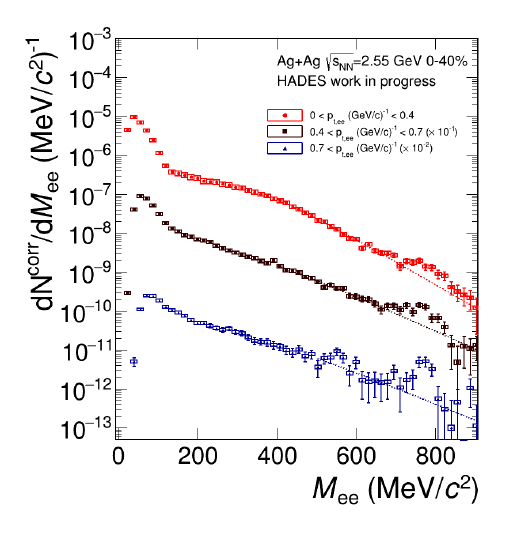
Figure 6. Dielectron signal in bins of the transverse pair momentum. With increasing momentum, significant modifications in the line-shape are observed. The dashed line is a fit to the thermal continuum ( dN / dM ee ∝ M 3 / 2 ee exp ( − M ee / kT )).